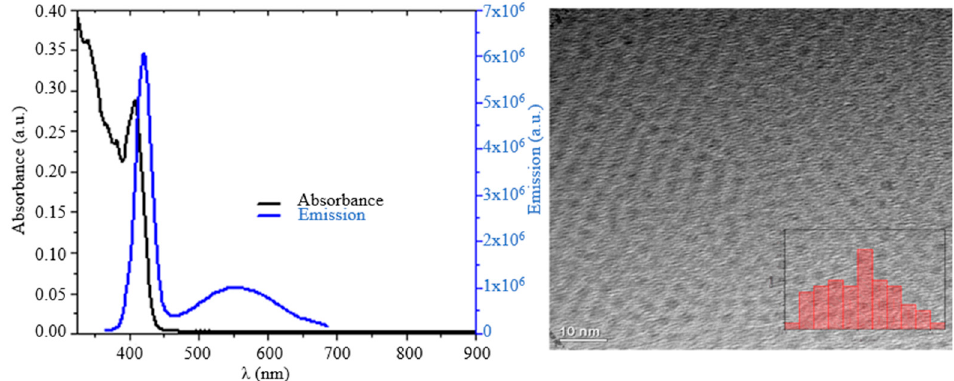
Figure 1. ( Left ) Absorption (black) and emission (blue) of CdS NPs. The sample was excited at a wavelength of 380 nm. The excitonic peak was 405 nm, as shown in the absorbance profile. ( Right ) TEM image of CdS NPs. The average diameter, shown by inset, of the CdS NP was 3.01 nm with σ = 0.23 (3.01 ± 0.23 nm).